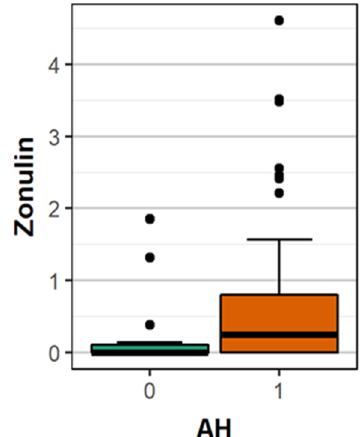
Figure 3. The comparison of the mean concentration of ZO-1 between patients with- and without arterial hypertension. arterial hypertension.